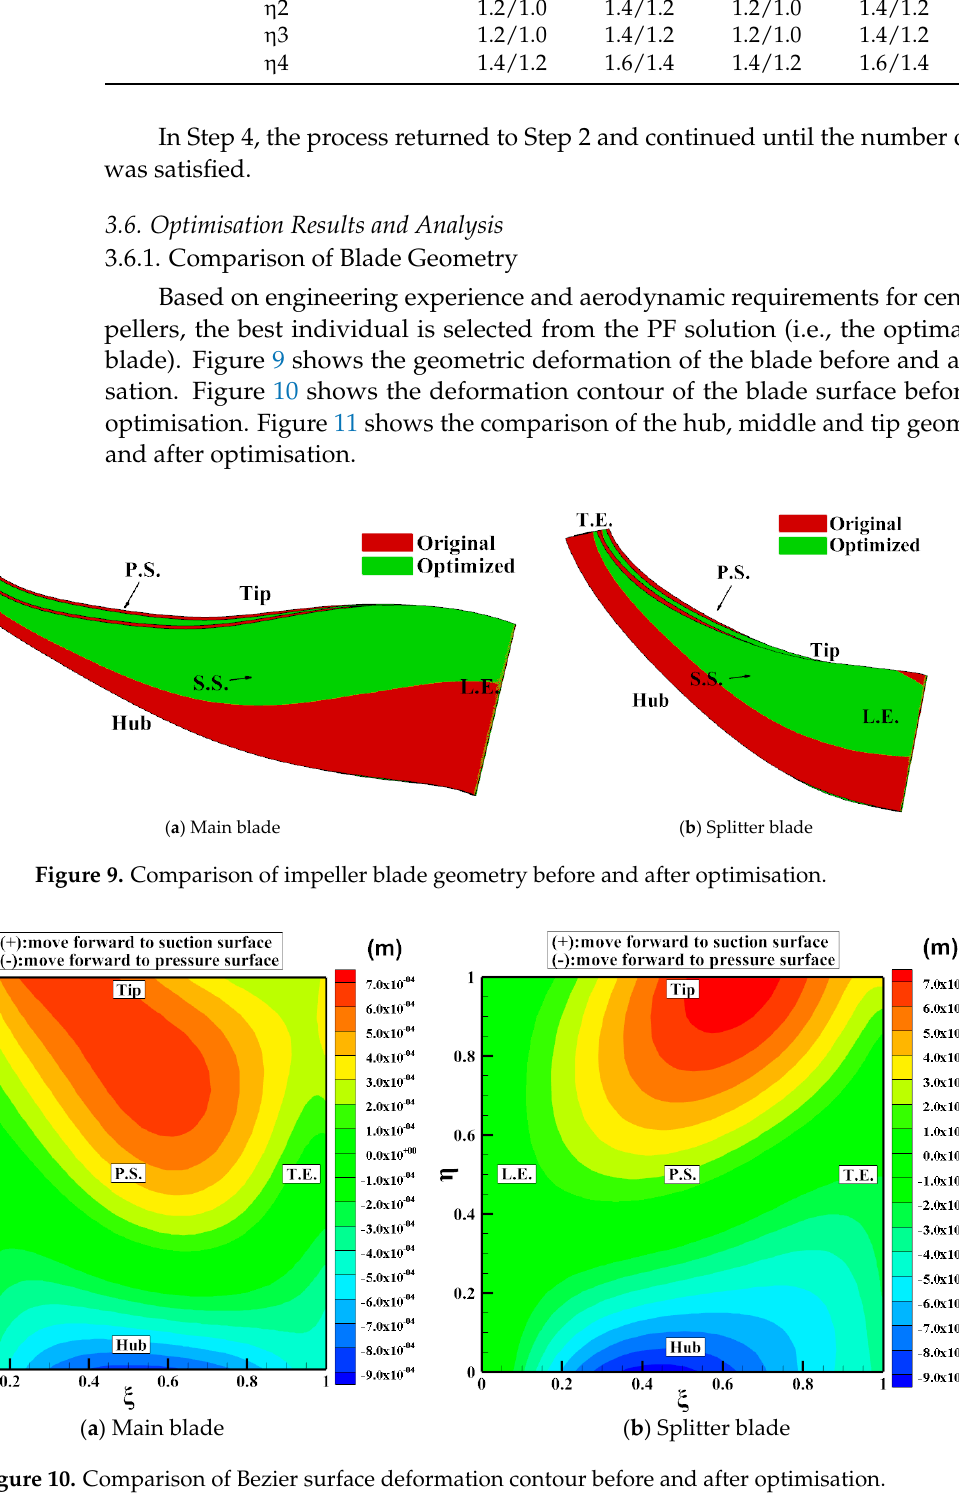
Figure 10. Comparison of Bezier surface deformation contour before and after optimisation.